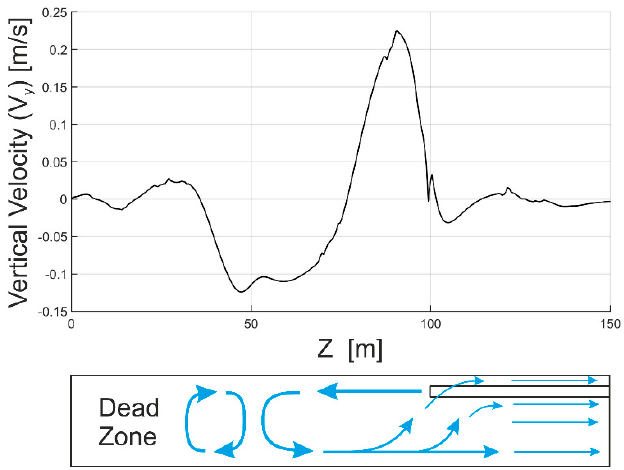
Figure 10. Mean vertical velocity along the tunnel axis for scenario 4 and inlet velocity 20 m/s.